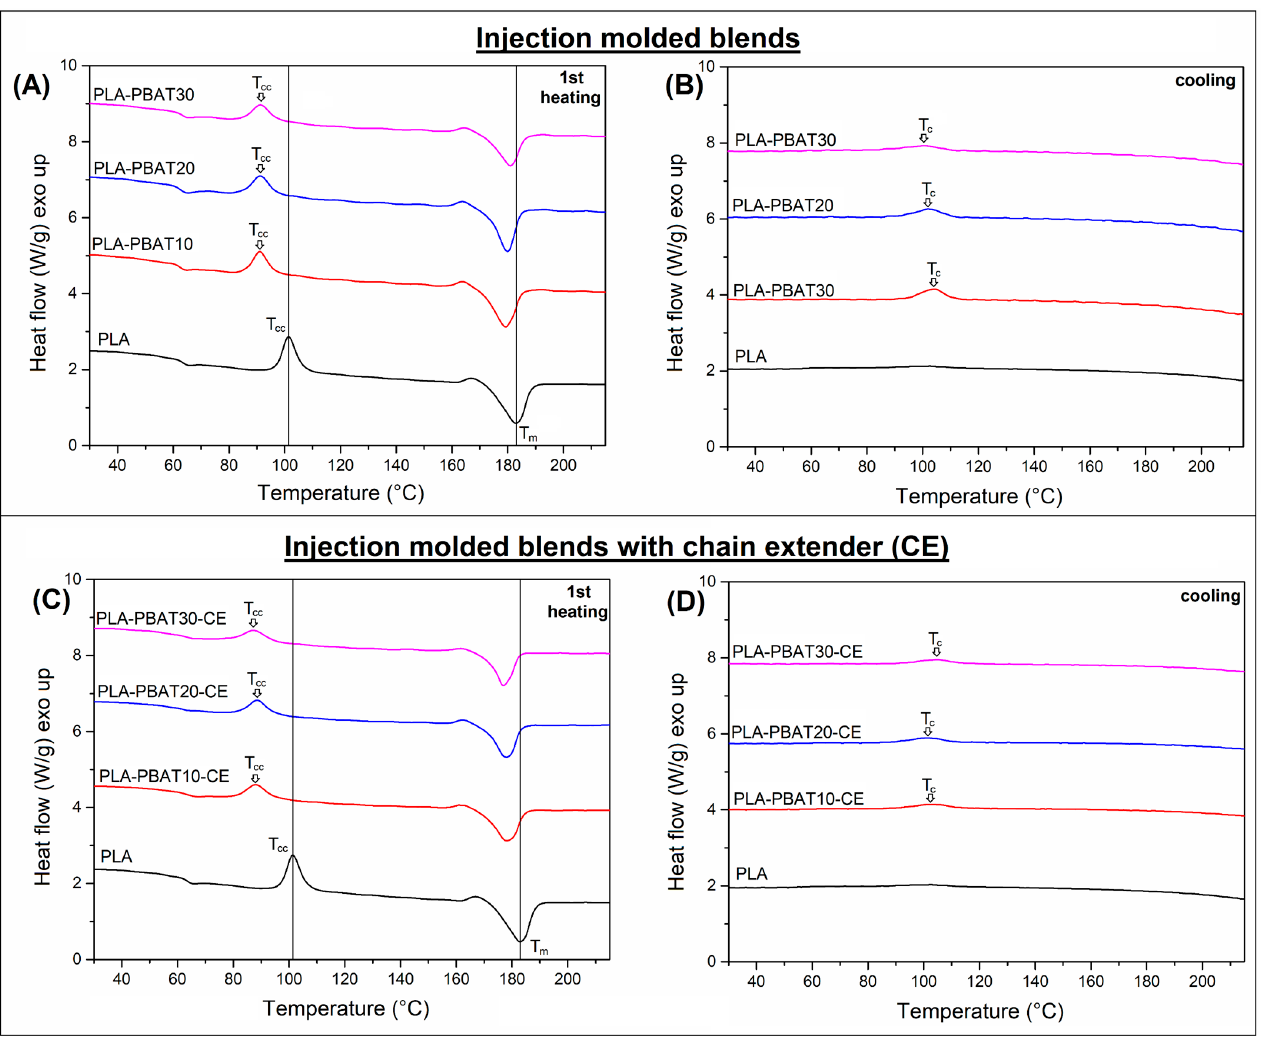
Figure 1. DSC thermograms for injection molded samples. The 1st heating and cooling DSC plots for ( A , B ) PLA-PBAT blends and ( C , D ) PLA-PBAT-CE materials.